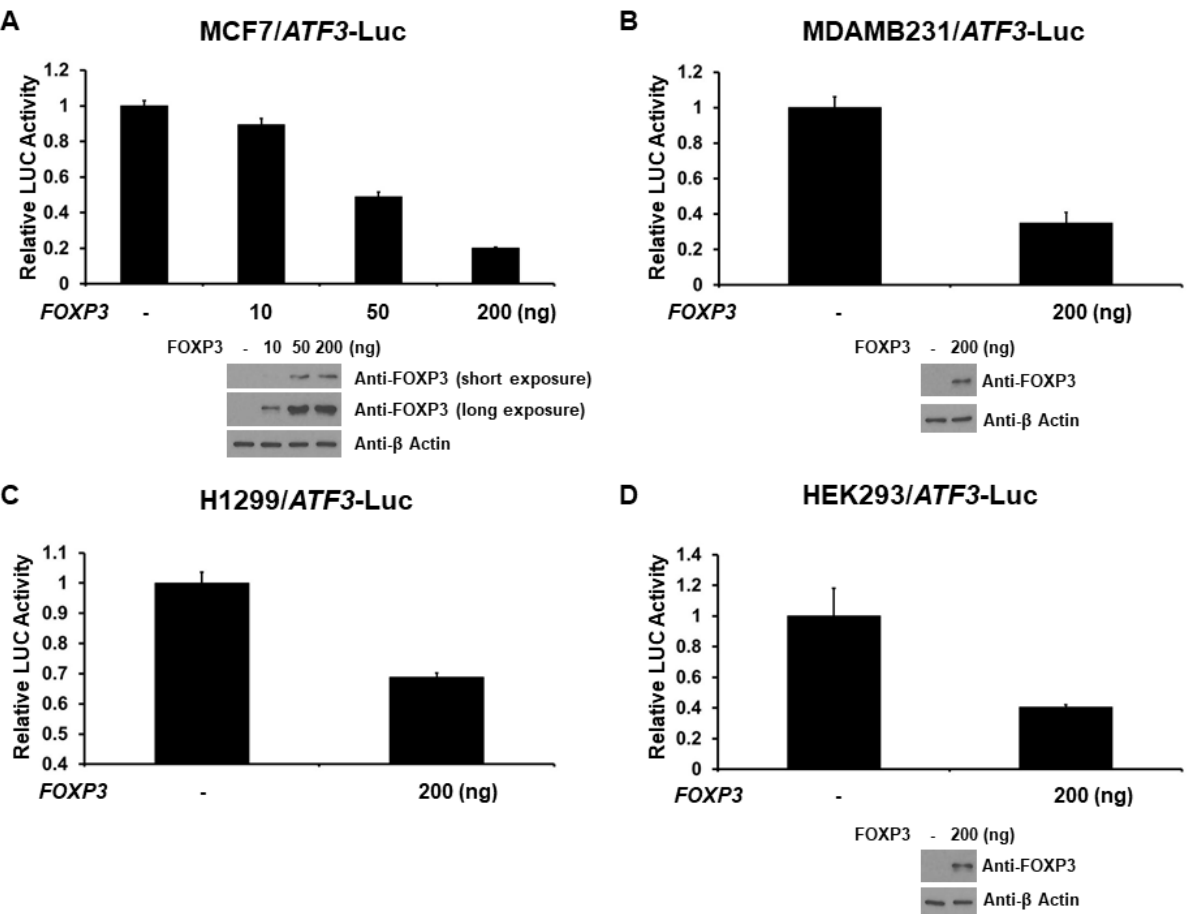
Figure 2. FOXP3 represses ATF3 transcription. ( A ) MCF7, ( B ) MDAMB231, ( C ) H1299, and ( D ) HEK293 cells were co- transfected, where indicated, with different amount of FOXP3 expression plasmid and ATF3 promoter-LUC reporter plasmid. Luciferase activities were measured 48 h after transfection and normalized with Renilla activity. Relative LUC activity was calculated and plotted. The protein levels of FOXP3 and β Actin in the cells from the reporter assays were confirmed using anti-FOXP3 and anti-β Actin immunoblotting, respectively.